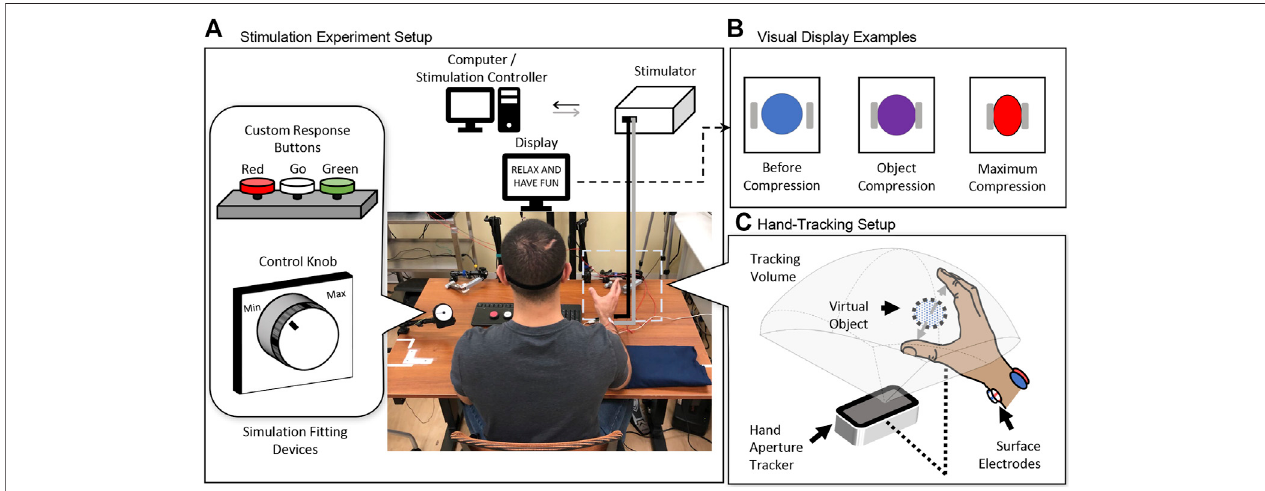
FIGURE 2 | Schematics of the experimental setup for stimulation parameter fi tting and virtual object classi fi cation task. (A) During the stimulation parameter fi tting procedure,customresponsebuttonsandacontrolknobwereused. (B) Duringpracticetrials,thevisualdisplaywasusedtoshowchangesincompressionoftheobject as hand aperture changed. (C) The hand aperture tracker (Leap Motion Controller) was placed on the right side of the table.